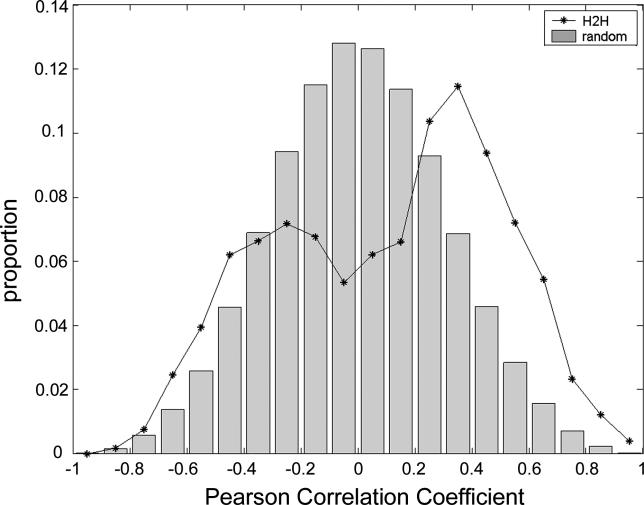
The Bimodal Distribution of the Expression Correlation between Head-to-Head Genesh2h, correlation distribution for head-to-head gene pairs, averaged over three distributions derived from three microarray datasets separately; random, correlation distribution for random pairs, also averaged over three random distributions from three microarray datasets.